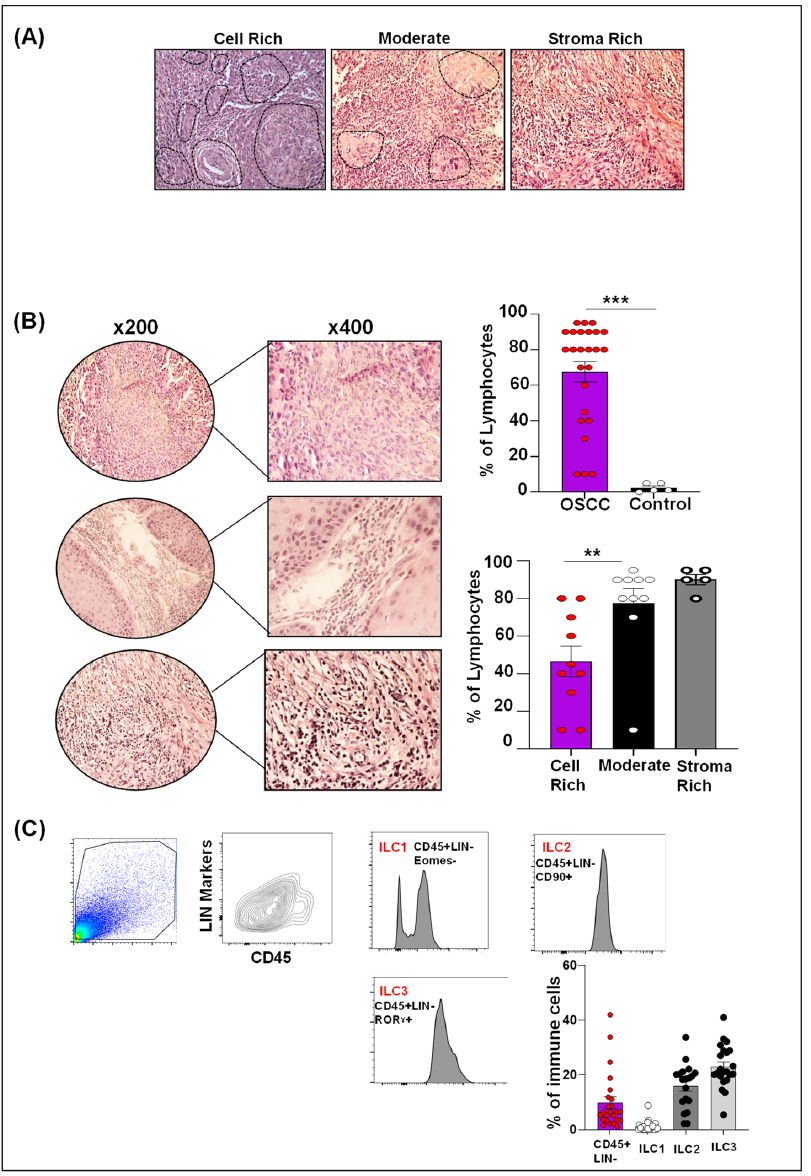
Figure 2. Lymphocyte and Innate lymphoid cells (ILCs) infiltration in human oral squamous cell carcinoma (OSCC). ( A ) Representative images of H & E-stained sections showing cell-rich, moderate, and stroma-rich areas (black dotted line showing tumor cells); ( B ) Evaluation of lymphocytes in cell-rich, moderate, and stroma-rich areas at x200 and x400 magnification. Increased lymphocytic infiltration in OSCC compared to control. Lymphocyte infiltration was highest in stroma-rich areas, followed by moderate and cell-rich areas. ( C ) Gating strategy and quantification of CD45+ Lin- cells, ILC1, ILC2, and ILC3 show increased infiltration of ILC3 (23%), followed by ILC2 (17%) and ILC1 (1%). ** p < 0.01, *** p < 0.0001.